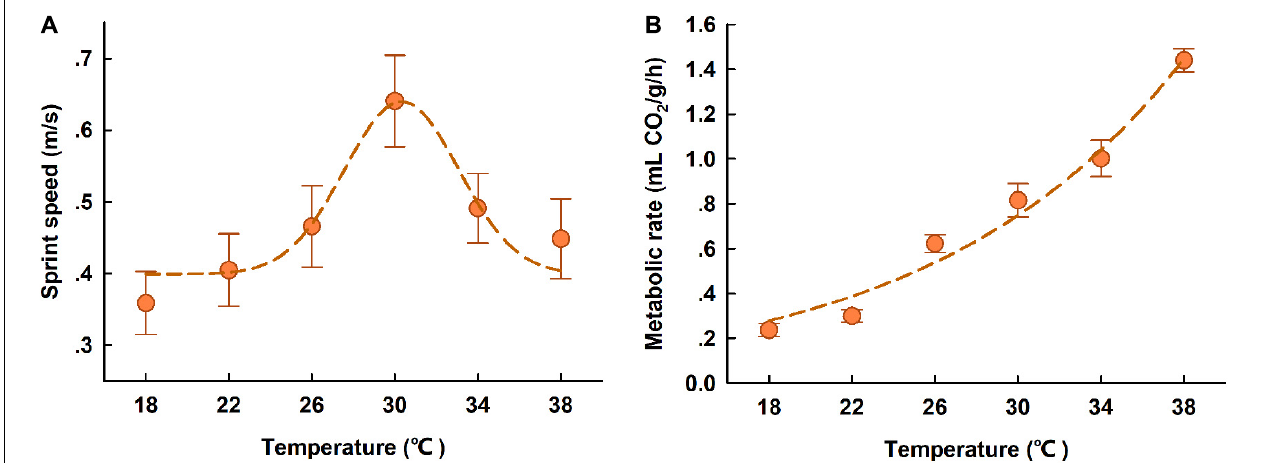
FIGURE 3 | Locomotor performance (A) and resting metabolic rates (B) of high-elevation T. kuehnei at different body temperatures. The spots indicate the sprint speed (A) and RMR (B) at each test temperature, and the dash lines indicate the regression. The data are shown as mean ± SE.